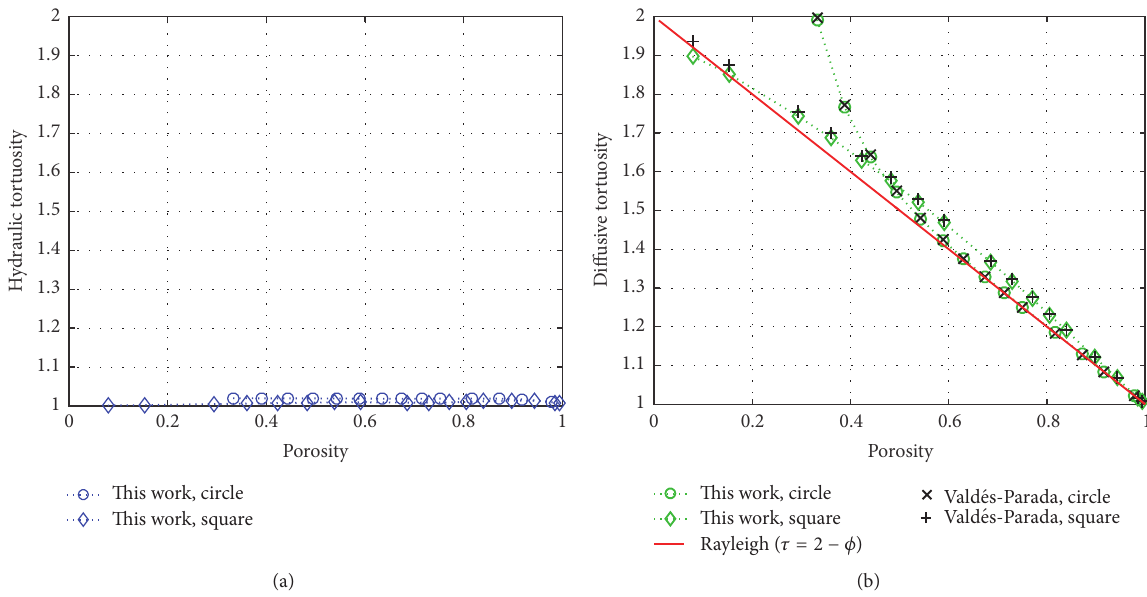
Figure 6: Tortuosity-porosity trends for in-line array of uniform shapes (circle or square). (a) Hydraulic tortuosity is a very weak function of porosity. (b) Diffusive tortuosity for in-line array of squares follows the analytical solution ( 𝜏 = 2 − 𝜙 ) from [48] closely, and both in-line array of squares and in-line array of circles match closely results by F. J. Vald´es-Parada (provided via personal communication, December 3,